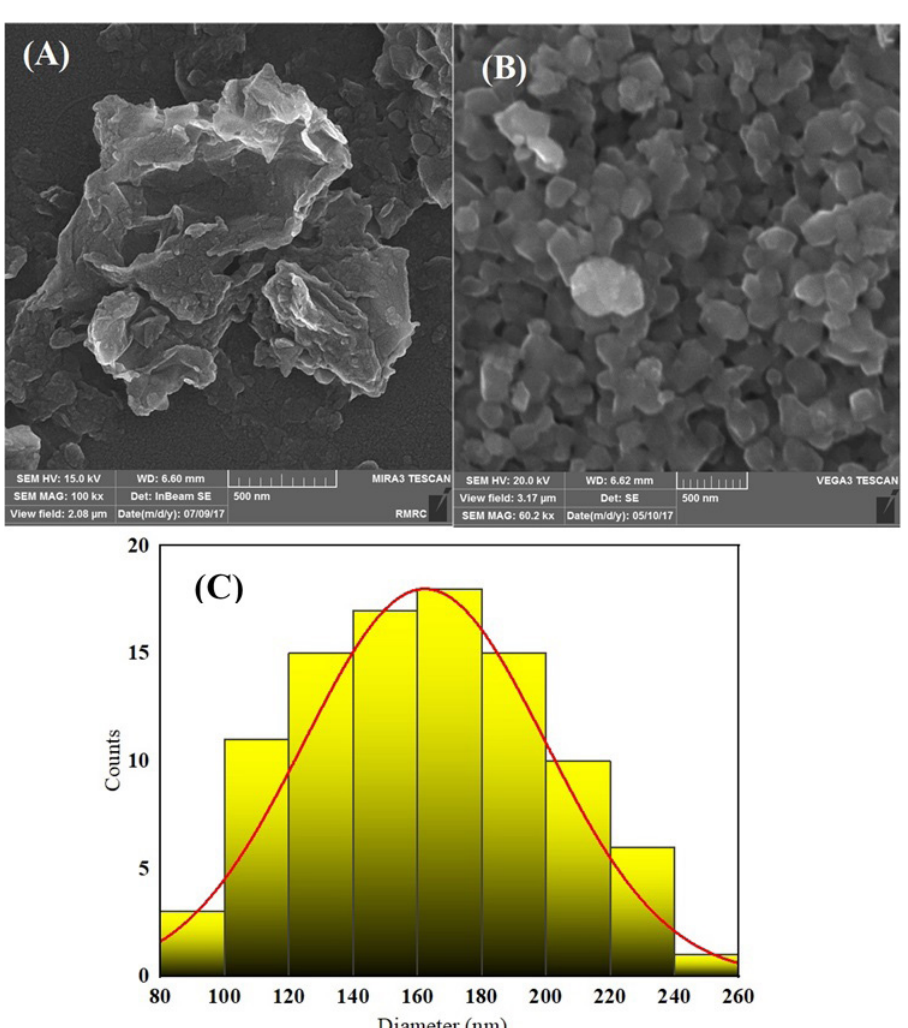
Fig. 1. FE-SEM images of RGO (A) and GO/TiO